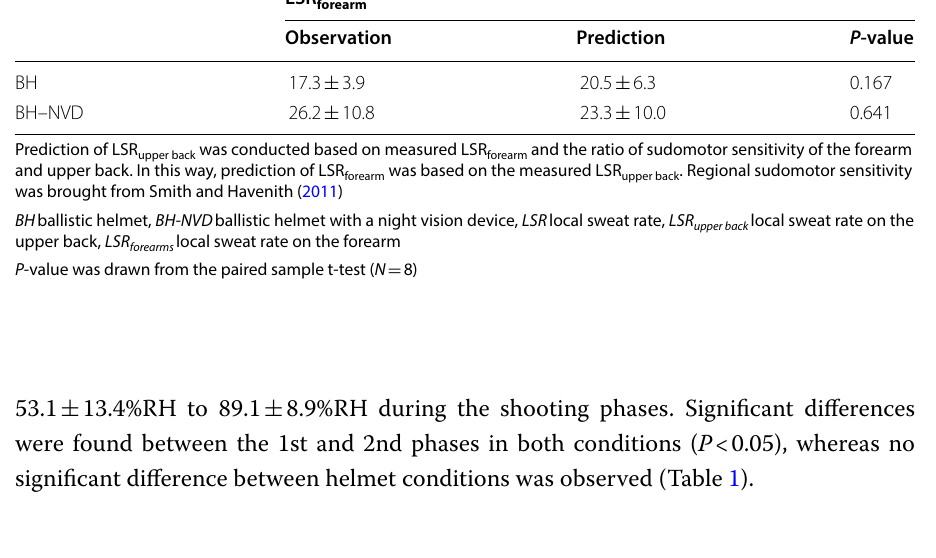
Table 2 Comparison of local sweat rate between measured outcomes and predicted values (Mean SD) ±